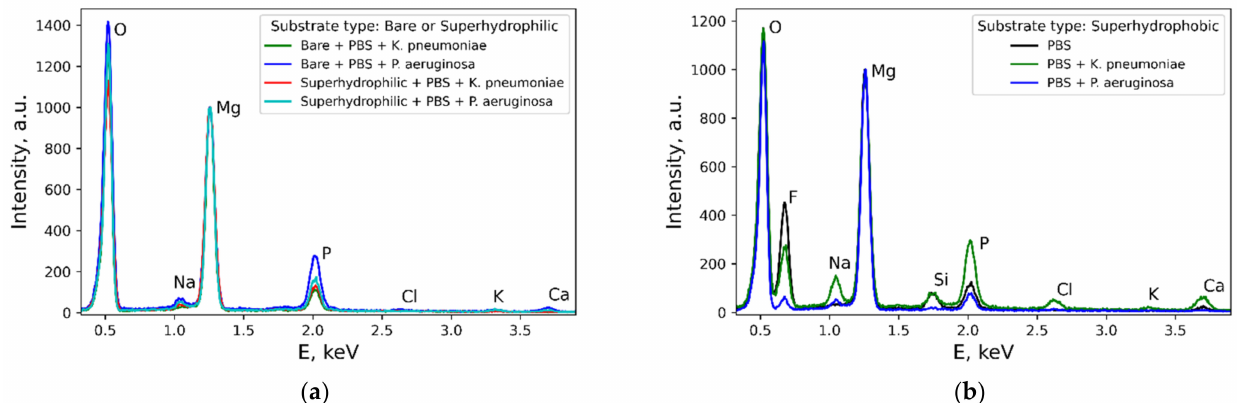
Figure 7. EDS spectra illustrating the elemental composition of the surface of metal samples with different wettability after 48 h of contact with bacterial dispersions: ( a ) Bare and superhydrophilic samples; ( b ) superhydrophobic samples. In the legend, “PBS” denotes a phosphate buffer solution without bacteria, and the bacteria names denote the dispersion of the corresponding bacterial strain in